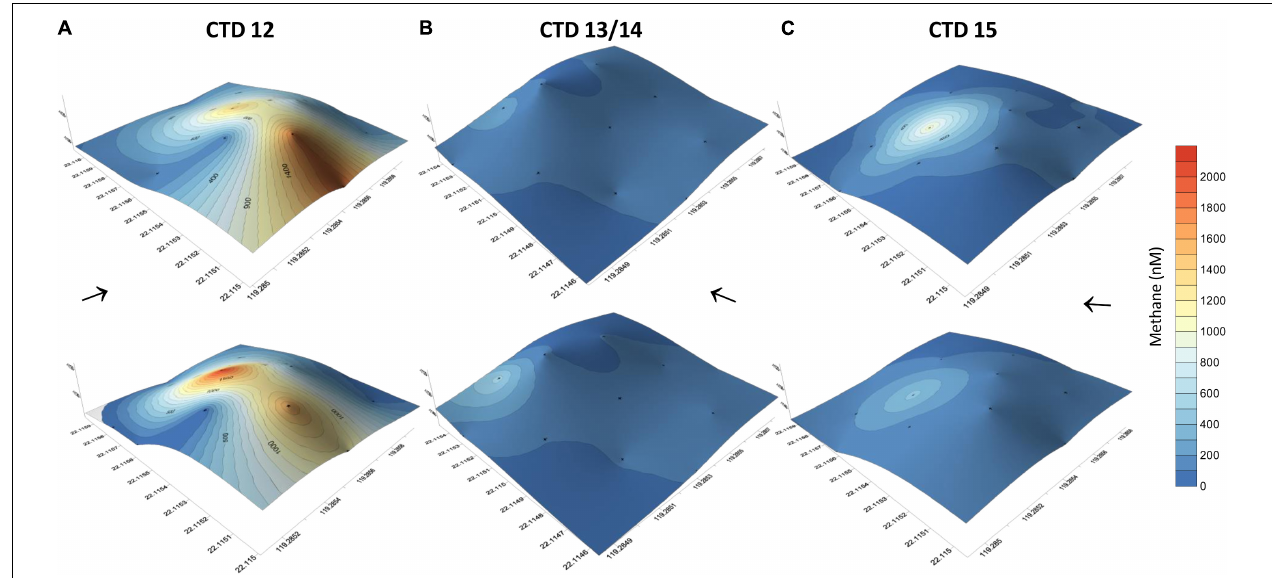
FIGURE 6 | Methane concentrations of water collected at 12 sites using a 4 × 3 point grid that covered the entire carbonate patch at SSFR, see map Figure 1A . Methane concentrations are plotted on the topography of the mound. The grid was sampled first during hydrocast CTD-12 (A) and repeated after 1.5 day (CTD-13/14) (B) . Another repetition was implemented after 0.5 days (CTD-15) (C) . During the first repetition, the grid was moved to the SW (see Figure 1A ). At the 12 sites, water was sampled at ∼ 5 m (lower row) and ∼ 10 m above the seafloor (upper row). Black arrows indicate current